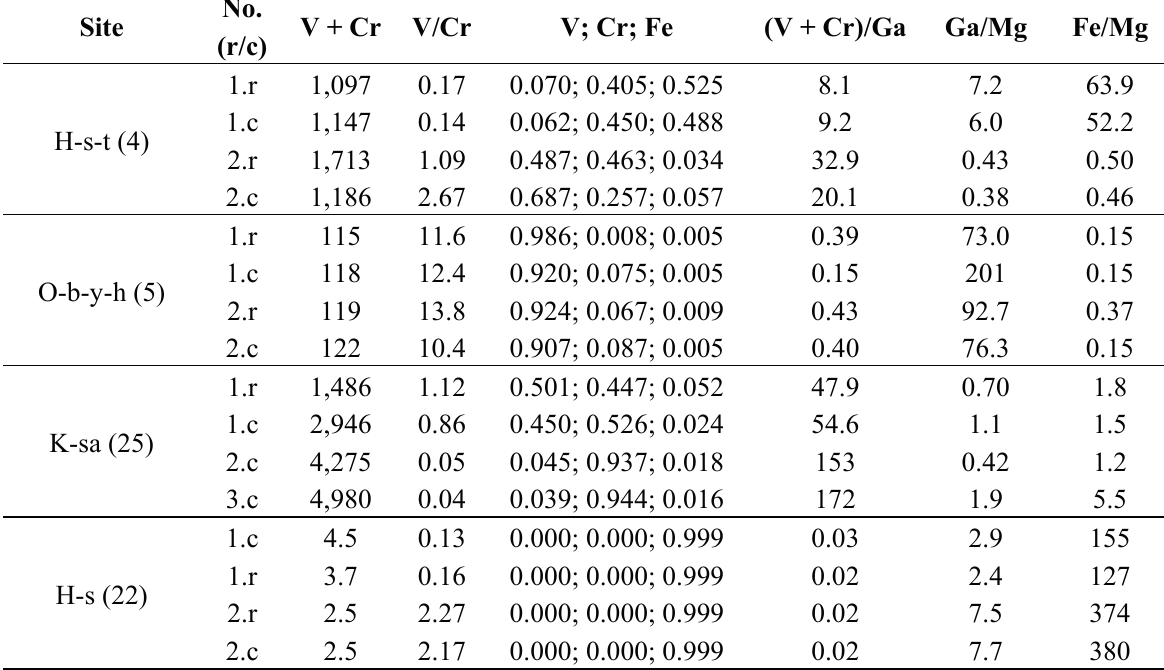
Table A1. Gem corundum V, Cr, Mg, Ga, Fe, values and ratios